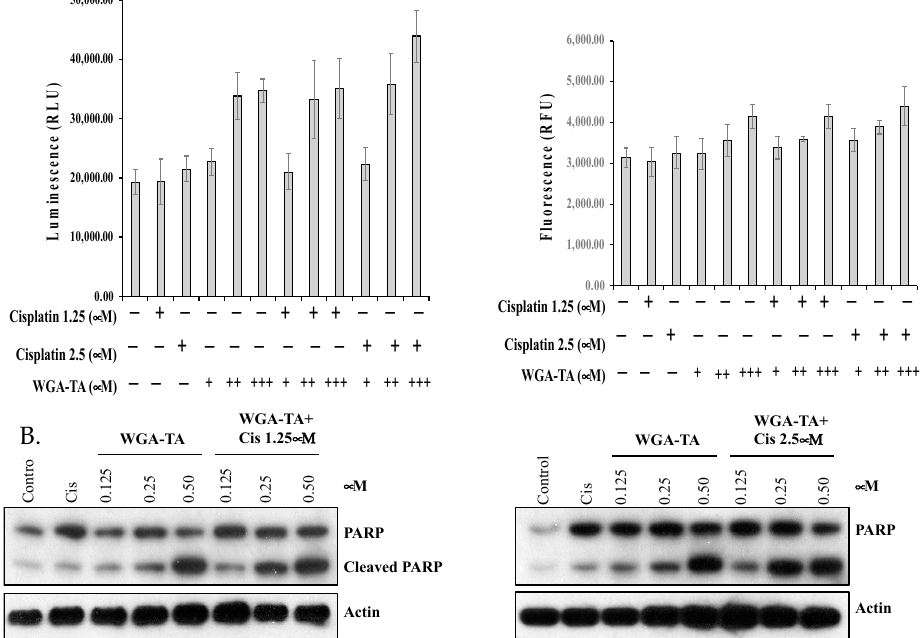
Figure 4. A ( Top ) . MDA1986 cells were treated either alone or in combination for 24 h. The induction of apoptosis and necrosis was detected using a RealTime-Glo annexin V apoptosis necrosis assay. The increase in luminescence induction of apoptosis and changes in fluorescence indicates the induction of secondary necrosis. B ( Bottom ) . Western blot showing treatment effect on protein markers for the induction of apoptosis. MDA-1986 cells were treated with either cisplatin or WGA-TA alone or in combination for 24 h. Post-treatment cells were immunoblotted for PARP. Actin was used as a loading control.